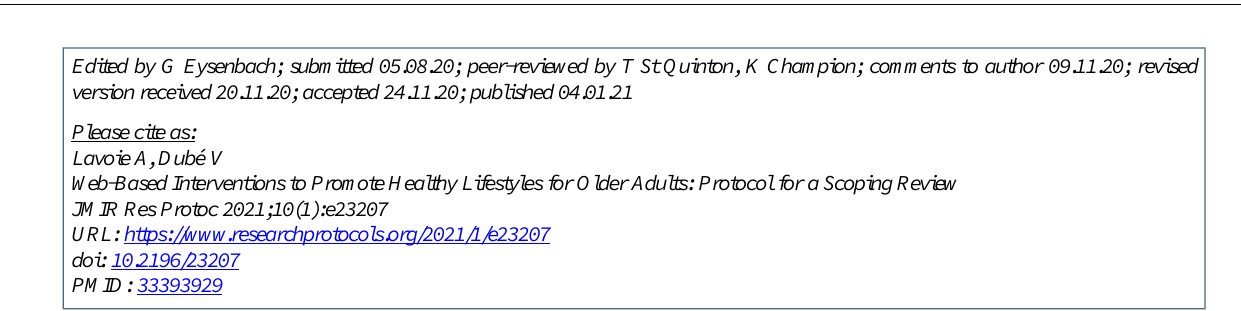
PRISMA: Preferred Reporting Items for Systematic reviews and Meta-Analyses